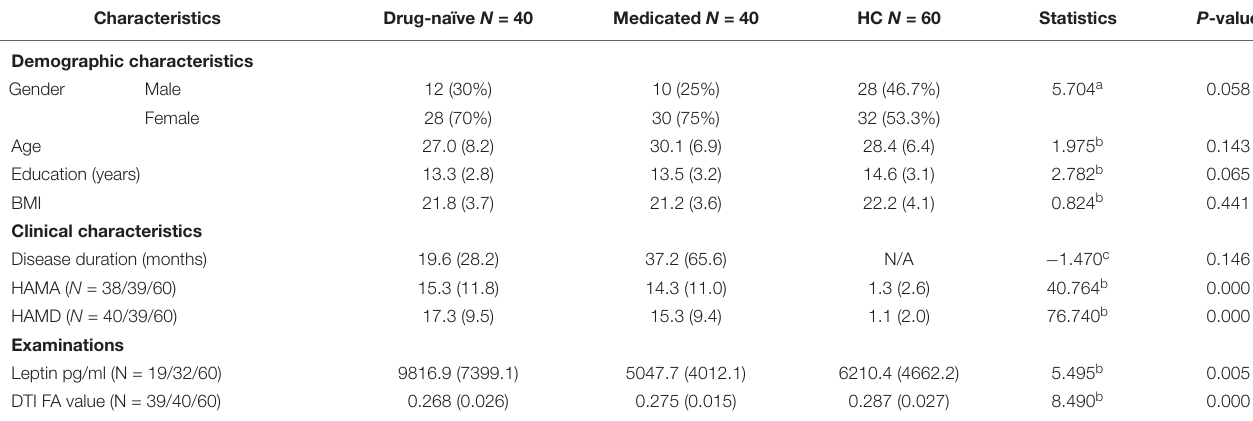
TABLE 1 | Demographic and clinical characteristics of all groups.